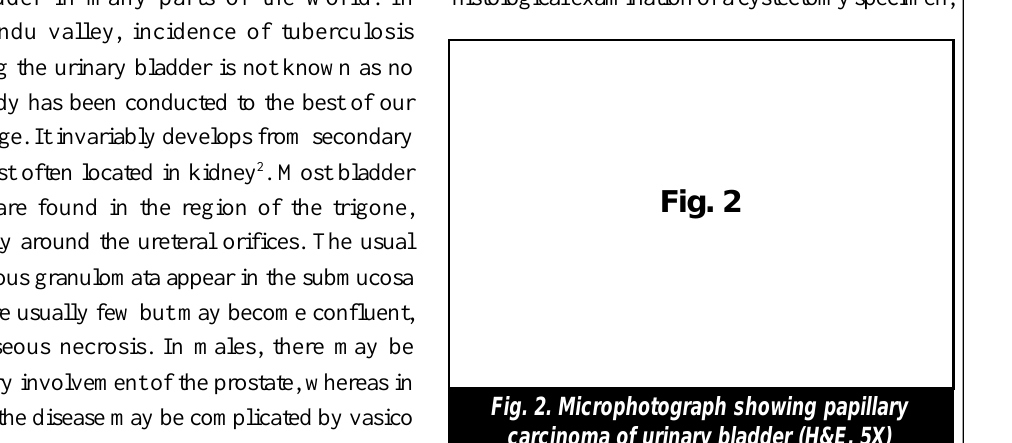
Fig. 2. Microphotograph showing papillary carcinoma of urinary bladder (H&E,